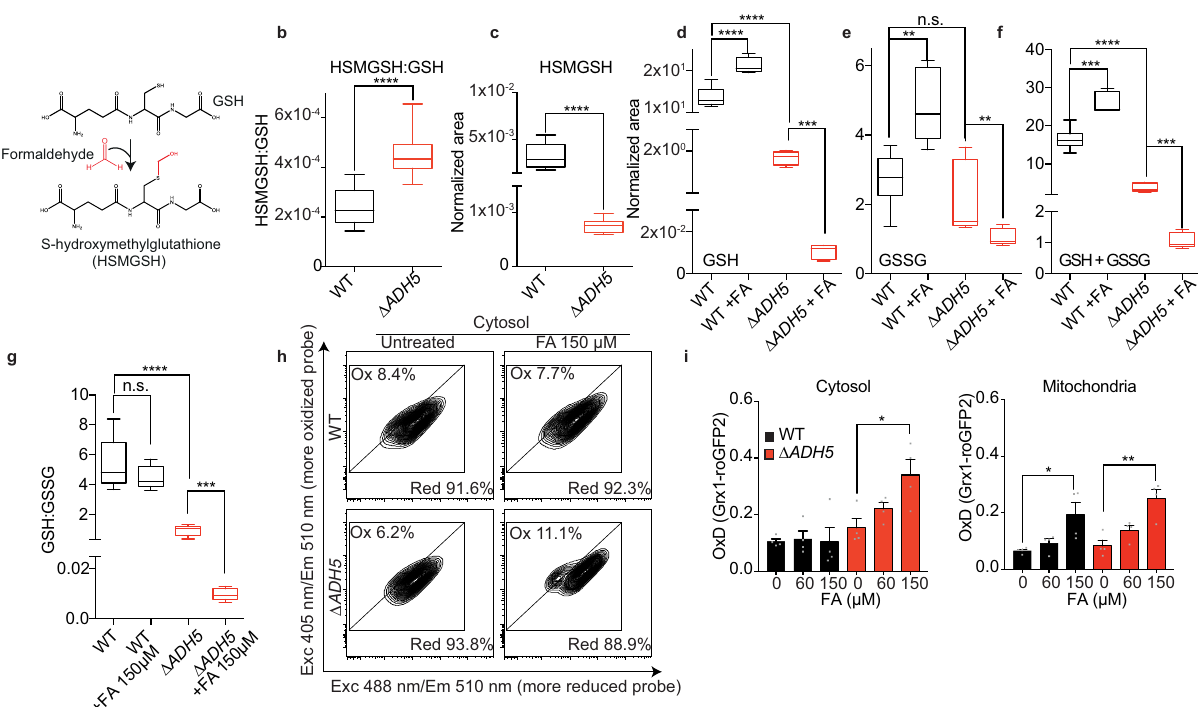
Fig. 6 Endogenous formaldehyde reacts with GSH altering the GSH:GSSG ratio. a Scheme showing the spontaneous reaction between formaldehyde (FA) and glutathione (GSH) yielding S-hydroxymethylglutathione (HSMGSH). b HSMGSH content relative to GSH in Wild type (WT) and Δ ADH5 HCT116 cells ( n = 9, two-tailed Mann – Whitney test, **** P < 0.0001). The box and whiskers plots: the line in the box corresponds to the median; the edges are the 25th and 75th percentiles, and the whiskers extend to the most extreme values. c Net HSMGSH content in WT and Δ ADH5 cells calculated as normalized peak areas relative to the number of viable cells ( n = 9, two-tailed Mann – Whitney test, **** P < 0.0001). Box and whiskers plotted as ( b ). d GSH content in WT and Δ ADH5 HCT116 cells exposed to 150 μ mol L − 1 FA over 48 h ( n = 9 for untreated (UT) WT and Δ ADH5 samples, n = 5 for WT and Δ ADH5 FA- treated samples, two-tailed Mann – Whitney test, *** P = 0.001, **** P < 0.0001). Box and whiskers plotted as ( b ). e GSH disul fi de (GSSG) content in WT and Δ ADH5 HCT116 cells exposed to 150 μ mol L − 1 FA over 48 h ( n = 9, WT and Δ ADH5 UT, n = 5 WT and Δ ADH5 FA-treated samples, two-tailed Mann – Whitney test, ** P = 0.002 (WT vs WT + FA), ** P = 0.0055 ( Δ ADH5 vs Δ ADH5 + FA), n.s.: not signi fi cant). Box and whiskers plotted as ( b ). f Total GSH (GSSG plus GSH) content in WT and Δ ADH5 HCT116 cells exposed to 150 μ mol L − 1 FA over 48 h ( n = 9 for untreated WT and Δ ADH5 samples, n = 5 for WT and Δ ADH5 FA-treated samples, two-tailed Mann – Whitney test, *** P = 0.001 (WT vs WT + FA), *** P = 0.001 ( Δ ADH5 vs Δ ADH5 + FA), **** P < 0.0001 (WT vs Δ ADH5 )). Box and whiskers plotted as ( b ). g . GSH:GSSG ratio in WT and Δ ADH5 HCT116 cells ( n = 9 for untreated WT and Δ ADH5 samples, n = 5 for WT and Δ ADH5 FA-treated samples, two-tailed Mann – Whitney test, **** P < 0.0001 (WT vs Δ ADH5 ), *** P = 0.001 ( Δ ADH5 vs Δ ADH5 + FA). Box and whiskers plotted as ( b ). h Flow cytometry representative plots from WT and Δ ADH5 HCT116 cells harbouring the cytosolic Grx1- roGFP2 reporter. i Quanti fi cation of oxidized Grx1-roGFP2 [OxD (Grx1-roGFP2)] ( n = 4, mean ± SEM, one-way ANOVA, Tukey ’ s test). Left: Cytoplasmic Grx1-roGFP2 ( Δ ADH5 0 vs Δ ADH5 + 150 µ mol L − 1 FA: * P = 0.0186). Right: Mitochondrial Grx1-roGFP2 (WT vs WT + 150 µ mol L − 1 FA: * P = 0.023,